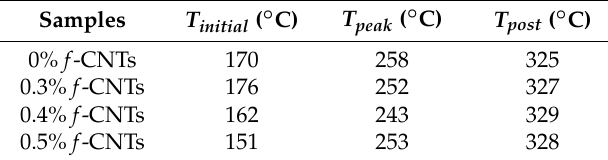
Table 2. Thermal properties of AG80/CE/h-BN with various contents of f